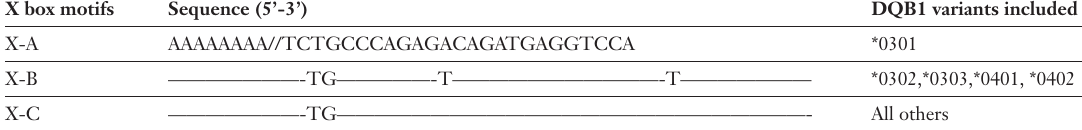
Note: The bases underlined construct palindromes